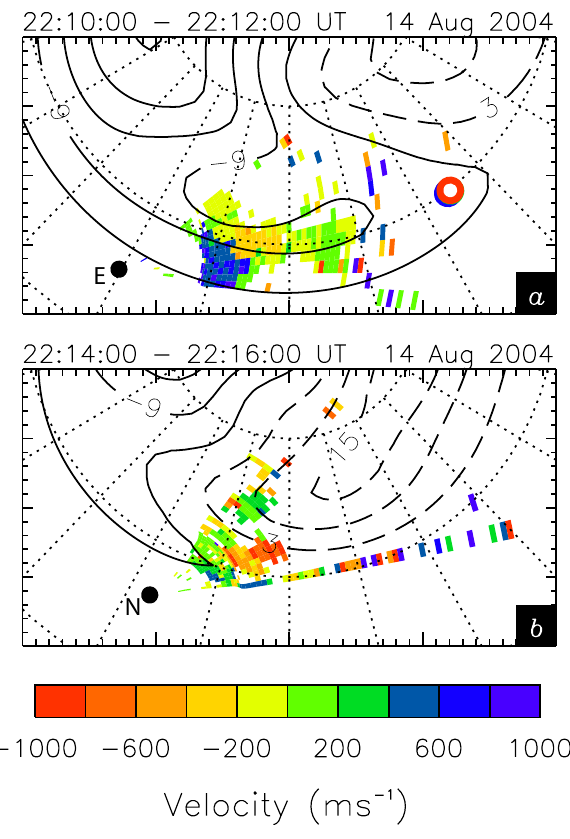
Fig. 2. (a) SuperDARN line-of-sight velocity data from the Iceland East radar at 22:10 UT on 14 August 2004 plotted on the same po- lar grid as in Fig. 1b. The data is colour coded according to the bar at the bottom, with positive velocities indicating flow towards the radar and negative velocities away. Contours of the ionospheric electric potential are superposed. (b) As (a) but for the Syowa East radar in the Southern Hemisphere at 22:14